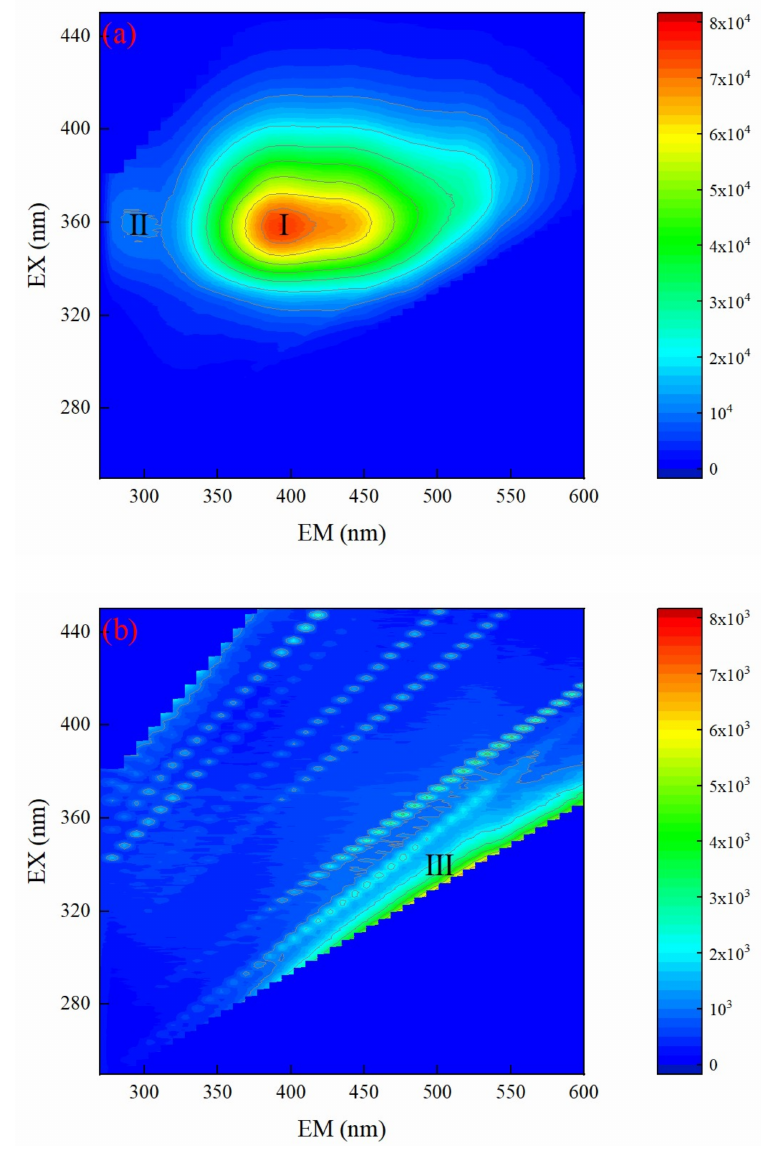
Figure 8. EEM analysis results: ( a ) raw water ( b ) degraded for 80